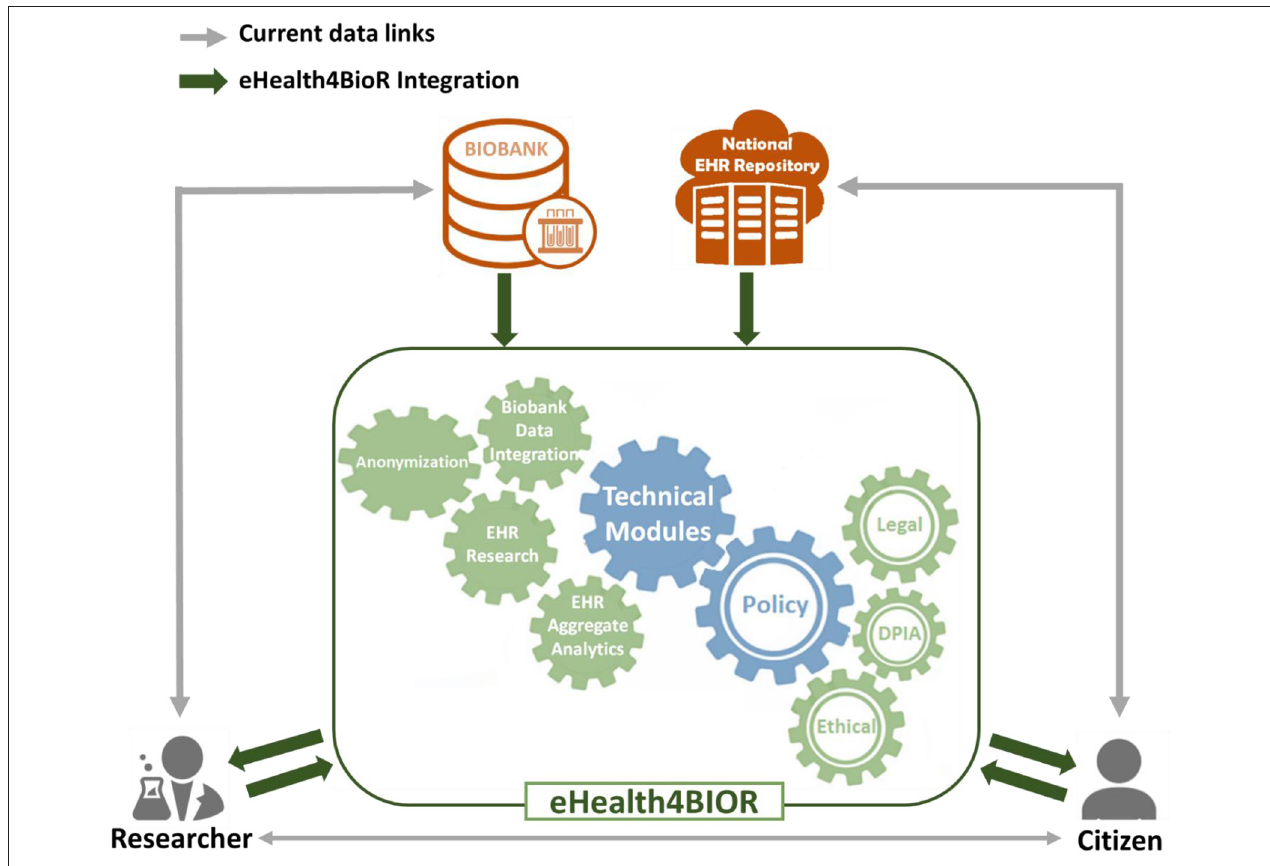
FIGURE 1 | eHealthBioR